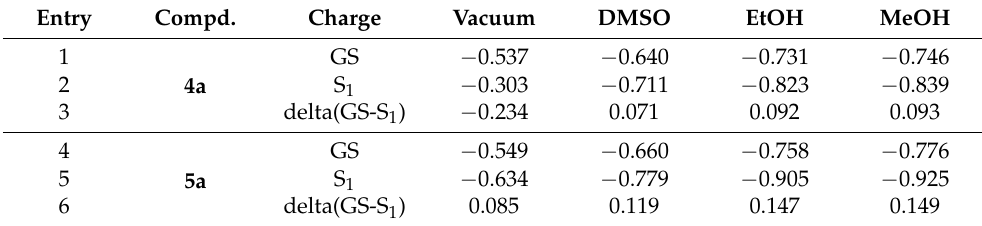
Table 7. Mulliken charges at the carbonyl oxygen atom of pyrones 4a and 5a